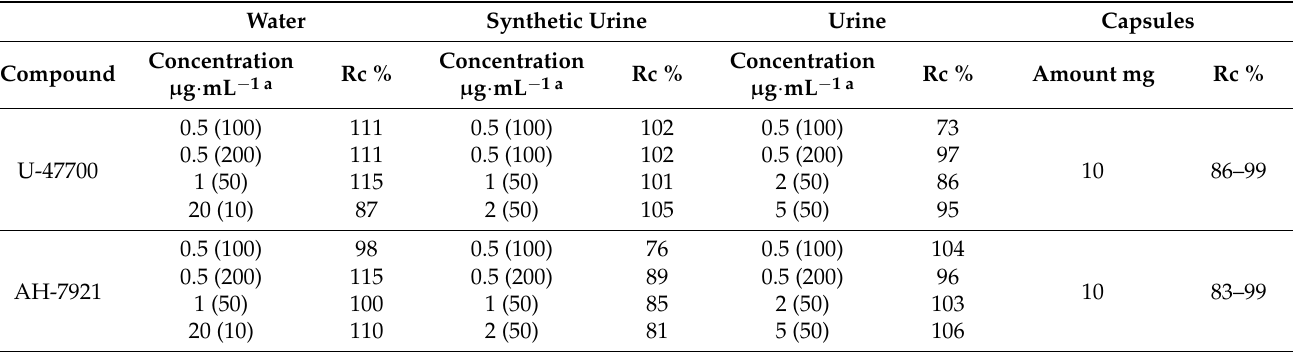
Table 5. Percentual recovery factor (Rc %) in water, synthetic urine, and real urine samples (number of replicates, n = 4) spiked with U-47700 and AH-7921 and in capsules containing 10 mg of one of the two